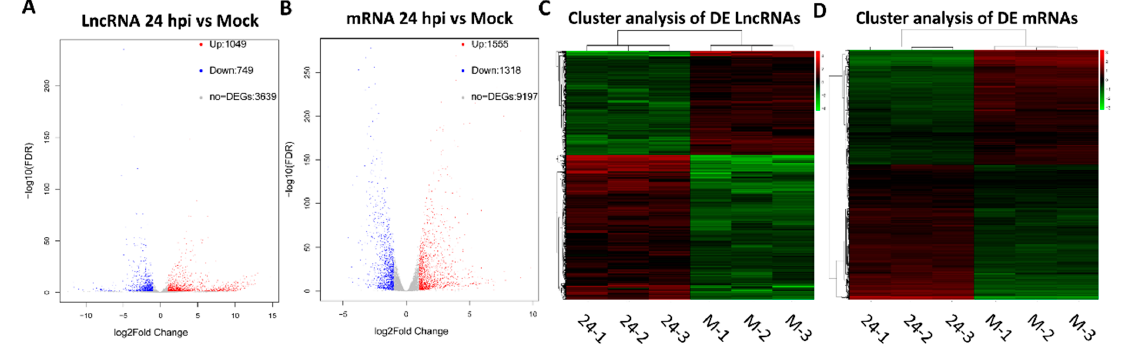
Figure 2. Differential transcription of lncRNAs and mRNAs in FAdV-4-infected and mock-infected LMH cells. Volcano plot diagram of the DE lncRNAs ( A ) and mRNAs ( B ) between FAdV-4 and mock infected cells. Hierarchical clustering of the DE lncRNAs ( C ) and mRNAs ( D ).